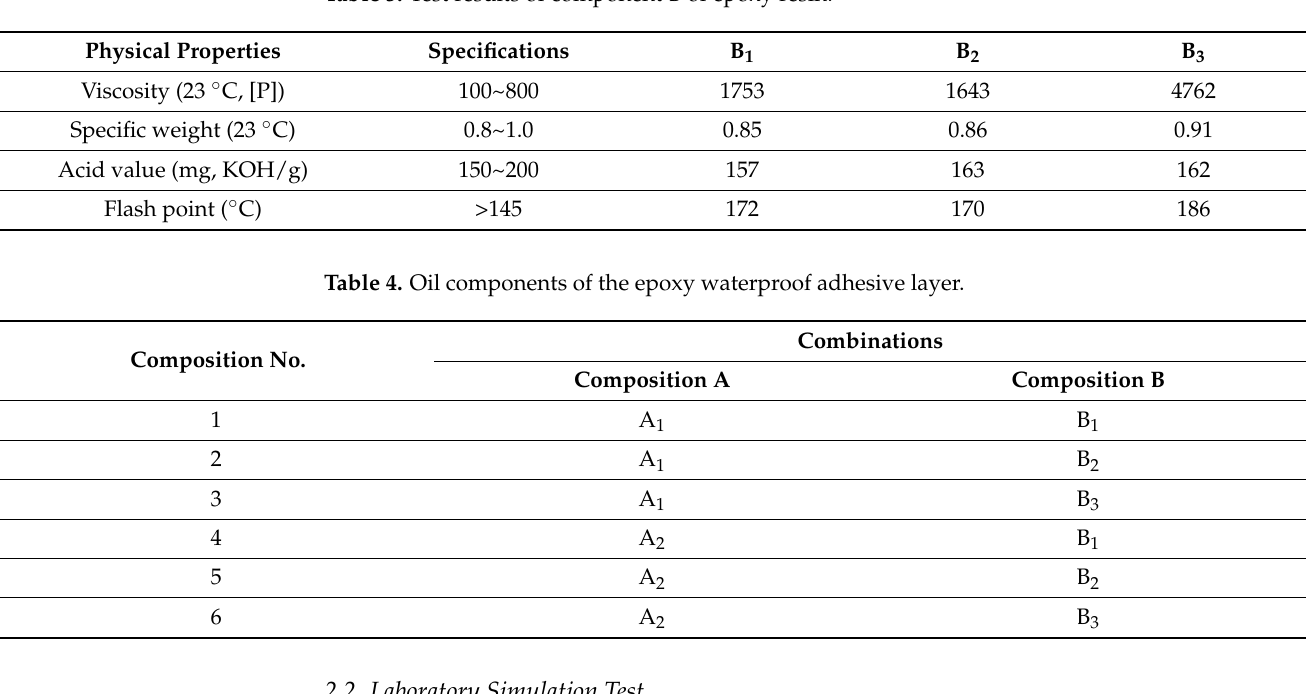
Table 3. Test results of component B of epoxy resin.